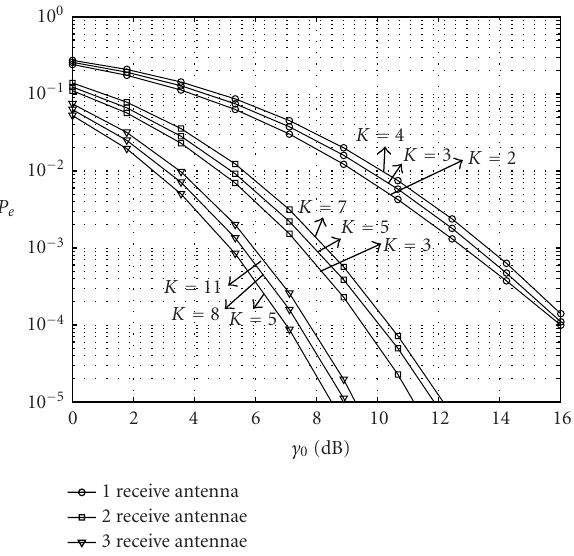
Figure 5: Probability of error for the nonblind ZF-like receiver versus γ 0 for di ff erent number of users and of receive antennae: M = 8, N = 4, and n t = 2 .